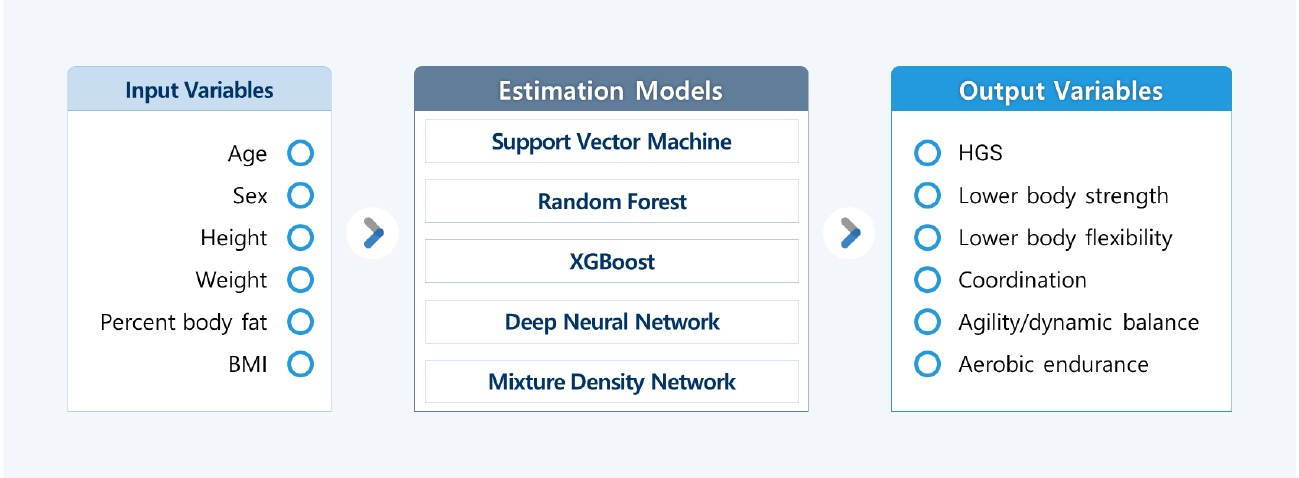
Figure 1. Summary of various regression models to predict FF variables with independent variables. Estimation models predicted each output variable. FF, functional fitness; BMI, body mass index; HGS, hand grip strength; XGBoost, extreme gradient boosting.